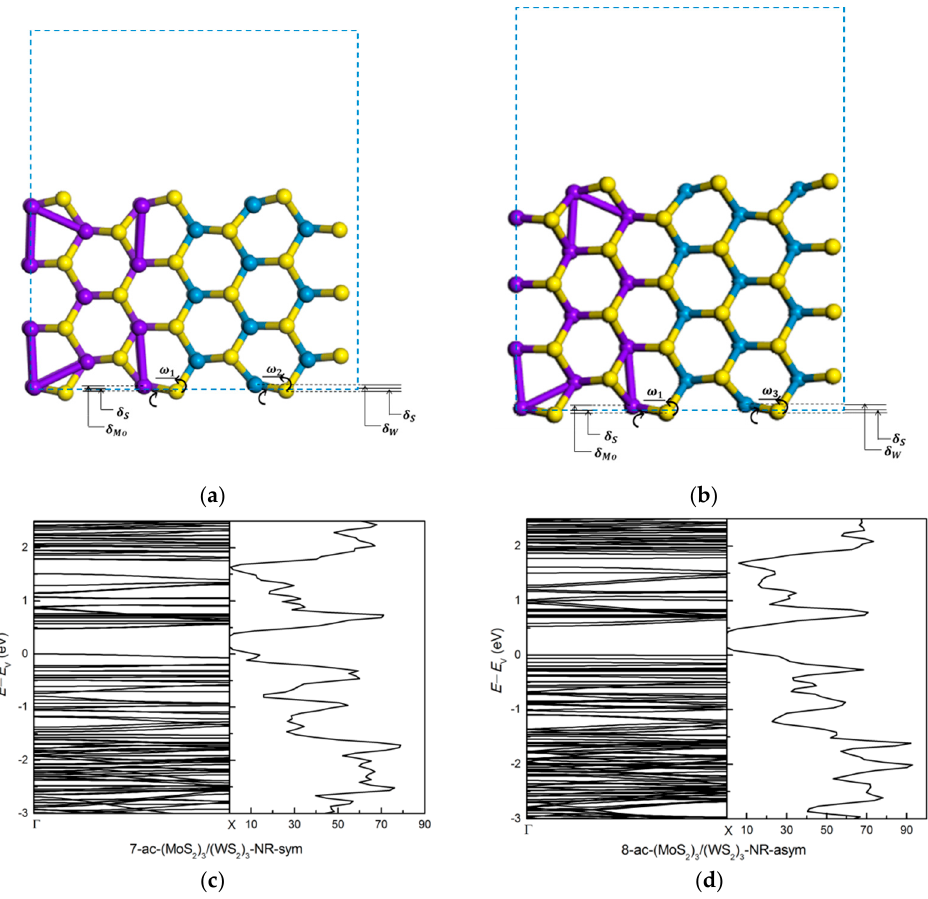
Figure 5. (a) The relaxed geometry of armchair (MoS 2 ) 3 /(WS 2 ) 3 nanoribbons: ( a ) 7-ac-(MoS 2 ) 3 /(WS 2 ) 3 -NR-sym, ( b ) 8-ac-(MoS 2 ) 3 /(WS 2 ) 3 -NR-asym. The δ Mo , δ W , δ S are the vertical displacement of the edge-layer Mo, W, S atoms which are relative to unrelaxed structures, respectively. The ω 1 and ω 2 are the angle of tilt of Mo-S bond and W-S bond from the horizontal line. The band structure and dos: ( c ) 7-ac-(MoS 2 ) 3 /(WS 2 ) 3 -NR-sym and ( d ) 8-ac-(MoS 2 ) 3 /(WS 2 ) 3 -NR-asym.